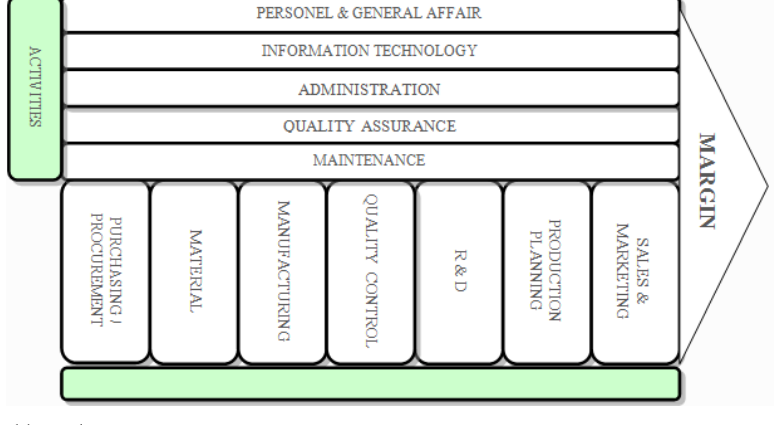
Fig. 3. Value chain of functional activities of a